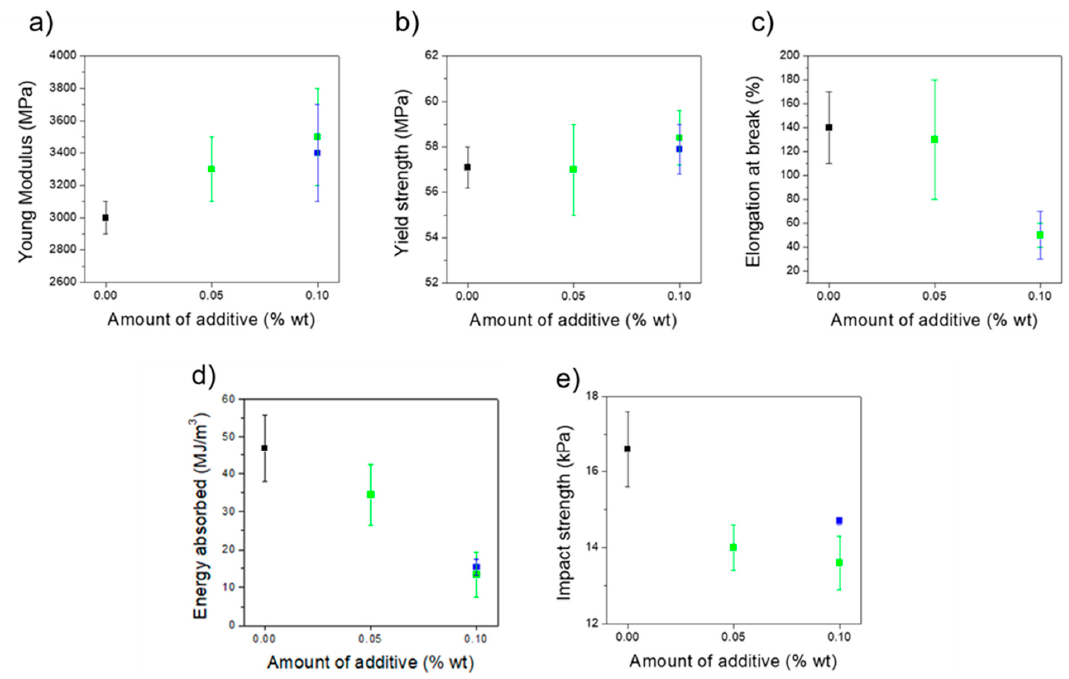
Figure 5. ( a ) Young modulus; ( b ) yield strength; ( c ) elongation at break, ( d ) energy absorbed from tensile experiments; and ( e ) impact strength of unmodified PLA/PHA (black), PLA/PHA+GNP (green), and PLA/PHA+AgNP (blue). Results are shown as a function of the amount of nano-additive used in the composite.